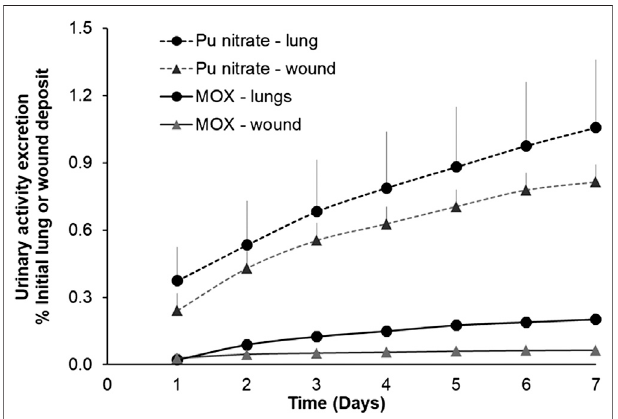
FIGURE 3 | Urinary excretion pro fi les following lung or wound contamination with MOX or Pu nitrate. Animals were contaminated with MOX by nose-only inhalation (12 kBq) or by a deposit into an incisional wound (13 kBq) as already described. For Pu nitrate pulmonary contamination wasbyintratracheal instillation (5.5 kBq) or awounddeposit (6 kBq).Dataare expressed as a percentage of the initial lung or wound deposit and are the means ± S.D. for three to six